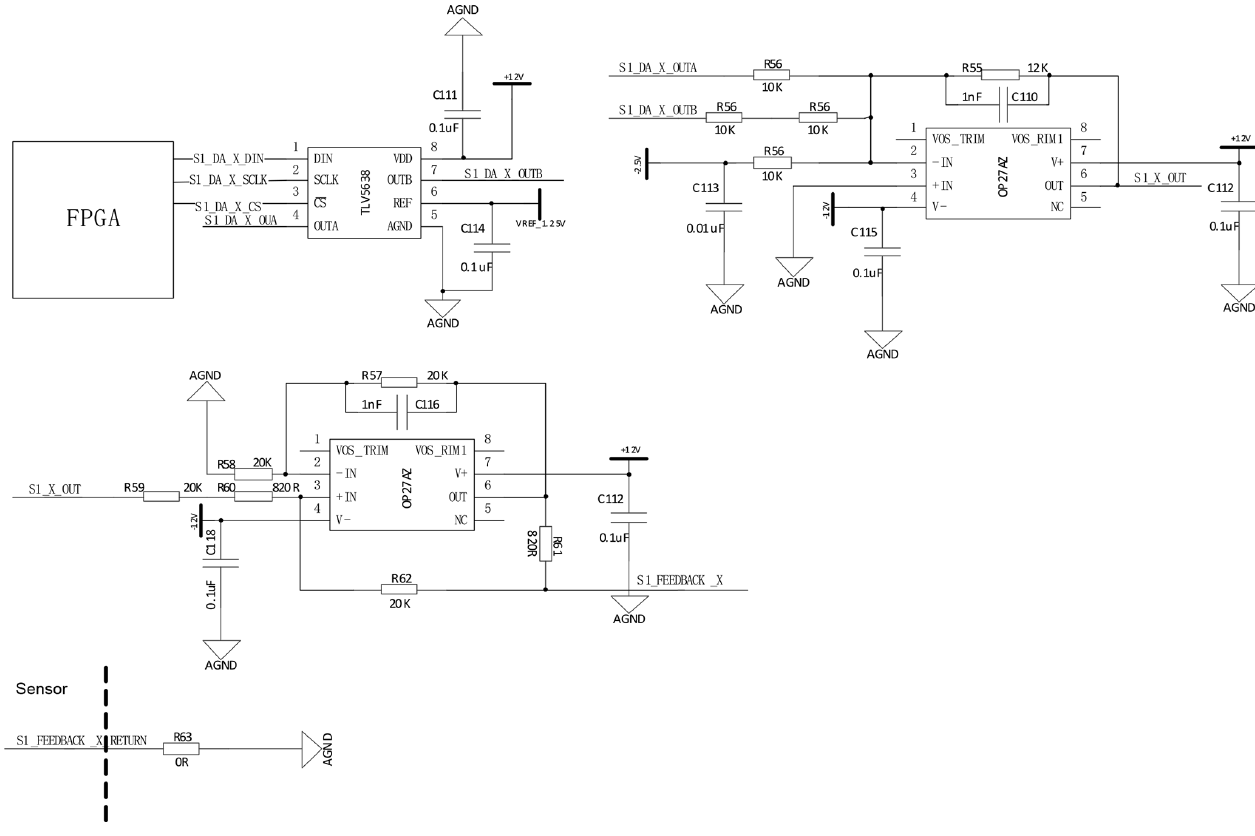
Figure 5. The block diagram of the feedback module